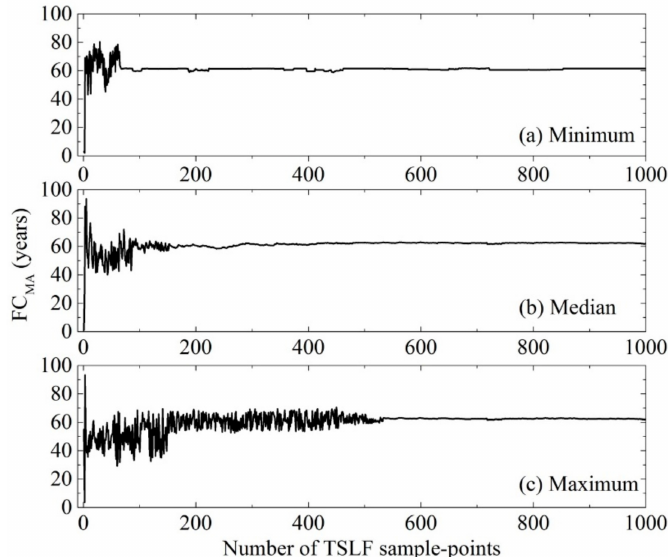
Figure 6. Three examples of how the FC MA estimate varied with the number of TSLF sample-points, using the TSLF map for the 2100 × 2100 grid simulated landscape that contained all 1200 fire-year maps. For example, the minimum required number of sample-points to obtain an absolute difference in the measured mean (ADMM) of 10% of the FC MA estimate is ( a ) 65, ( b ) 147 and ( c ) 571. Those values correspond to the minimum, median and maximum values in the distribution in Figure